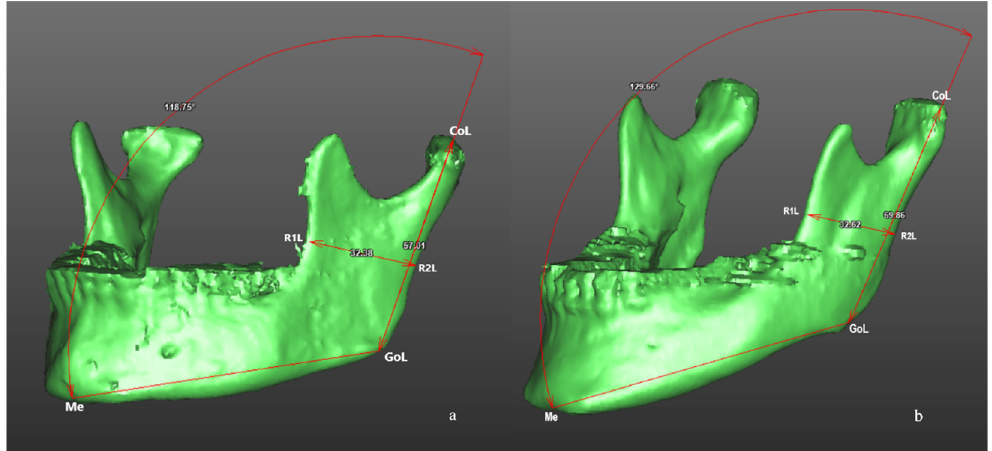
Figure 1. Morphometric analysis of the mandible after three-dimensional volumetric reconstruction of CBCT scans in a patient of L-GA group ( a ) and in a patient of H-GA group ( b ). Linear measurements included mandibular ramus high (Co-Go) and mandibular ramus width (R1-R2). Angular measurement included gonial angle (Condilion-Gonion-Menton; Co-Go-Me).